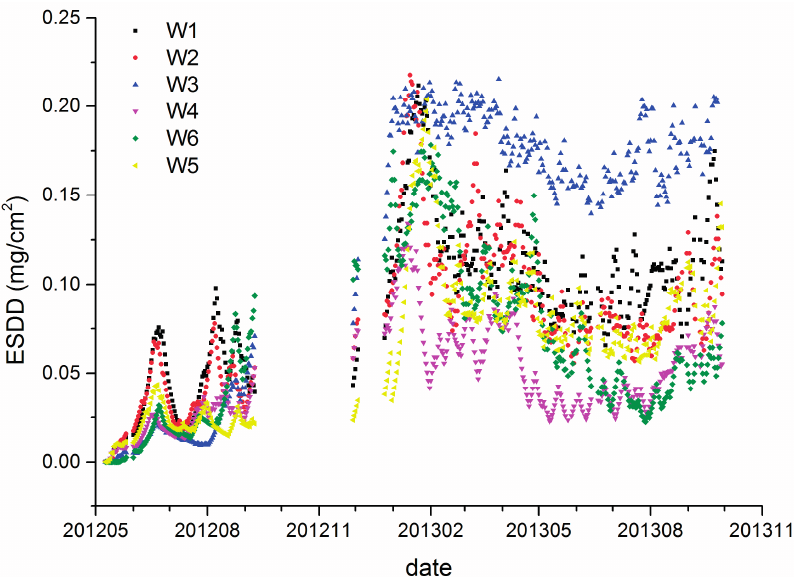
Figure 3. On-line measurements of six sites in